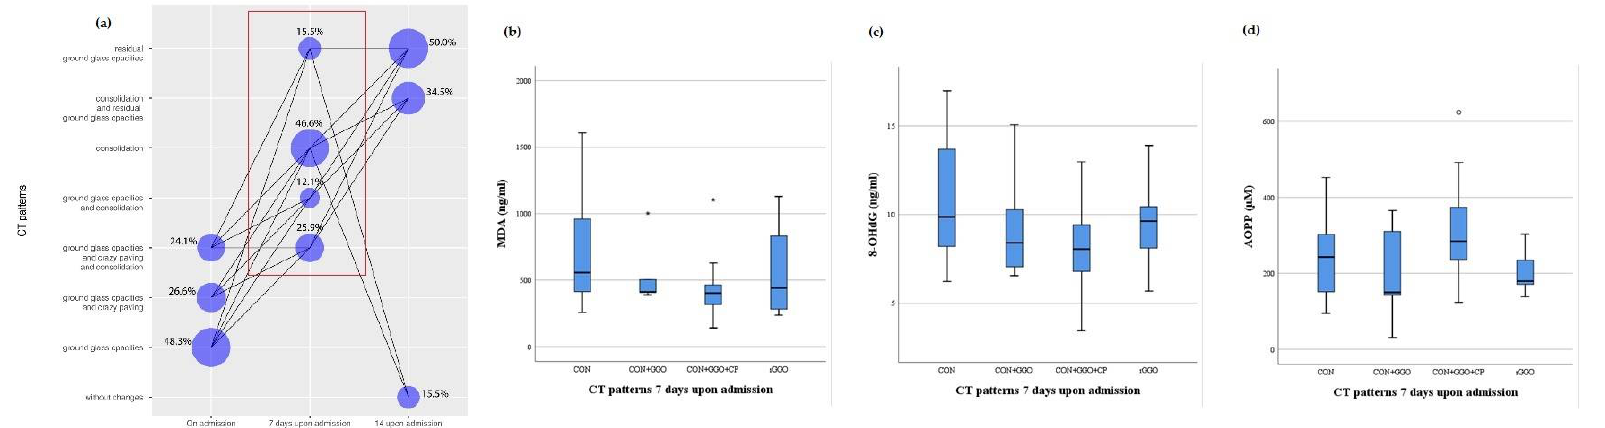
Figure 3. The frequency of CT patterns with their timely progression ( a ) and relation with the levels of MDA ( b ), 8-OHdG ( c ) and AOPP ( d ) in COVID-19 patients 7 days upon admission; GGO—ground glass opacities; CP—crazy paving; CON—consolidation; rGGO—residual ground glass opacities.